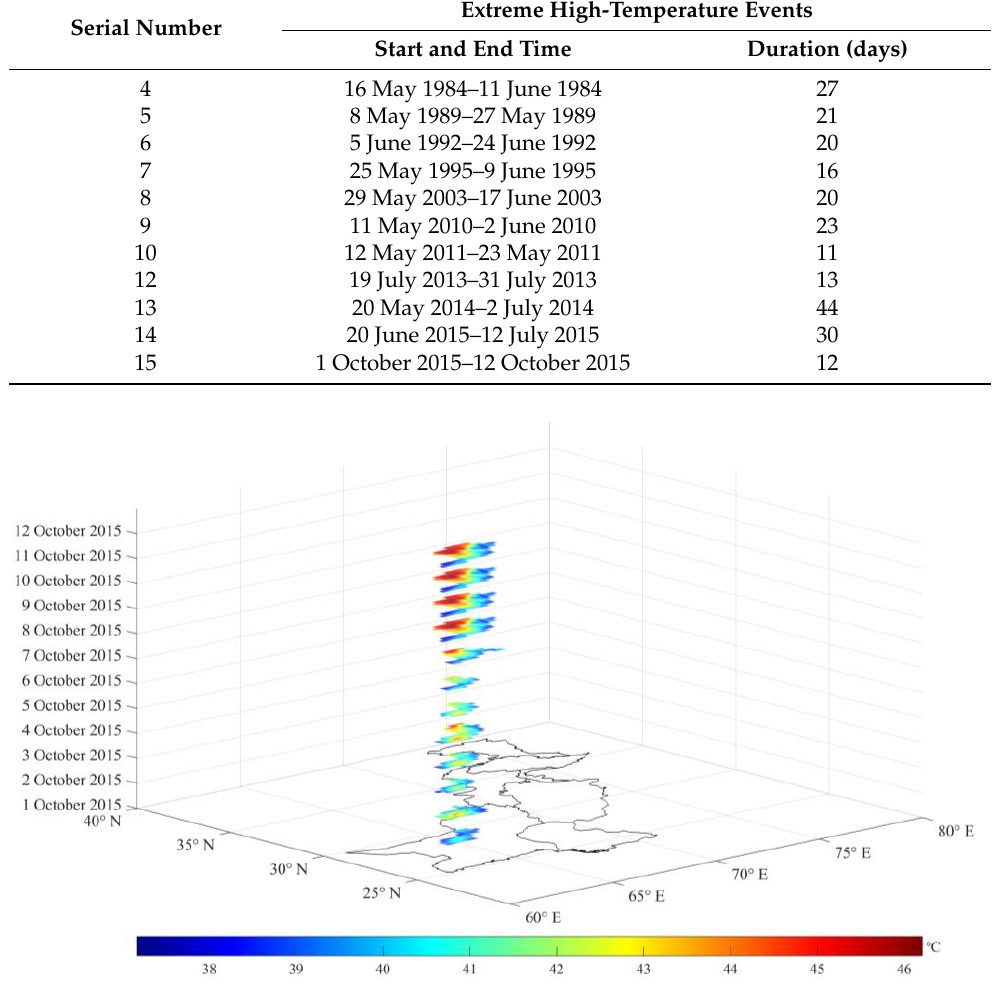
Figure 4. The extreme high-temperature event lasting for 12 days in the CPEC.